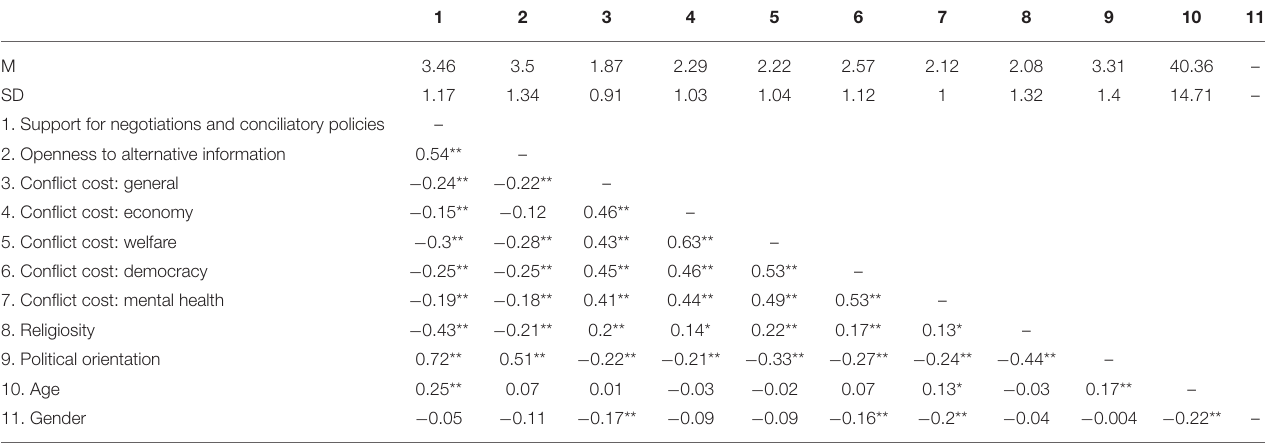
TABLE 1 | Means, SDs, and bivariate correlations among Study 1